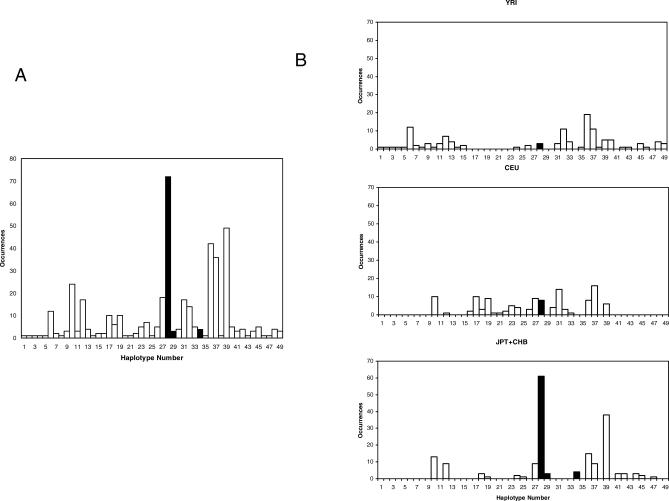

APOBEC3B Haplotype StructureThe deletion locus was coded as a bi-allelic variant, and phased haplotypes were constructed for the locus and all Phase II SNPs within 25 kb of the deletion. The black bars identify haplotypes that carry the deletion allele while the white bars carry the insertion allele. The number of occurrences for each haplotype is shown for all of the HapMap samples (A) and for each population separately (B).